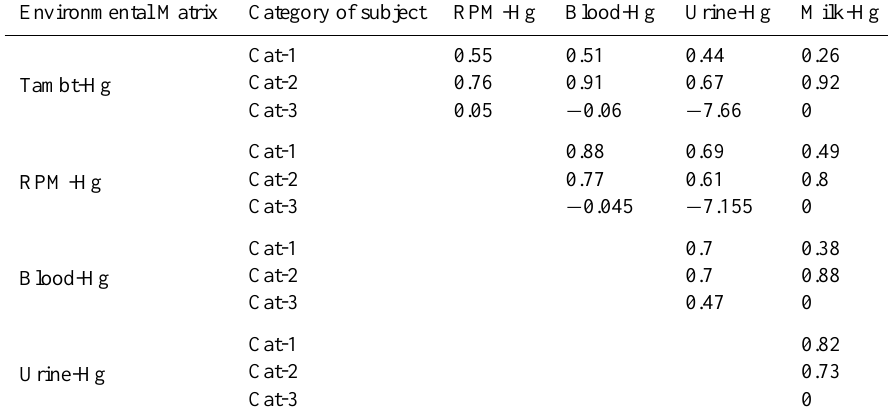
Table 5. Inter-correlation between mercury data of selected matrices of human exposure-dose study in the vicinity of steel plant, Bhilai. Environmental